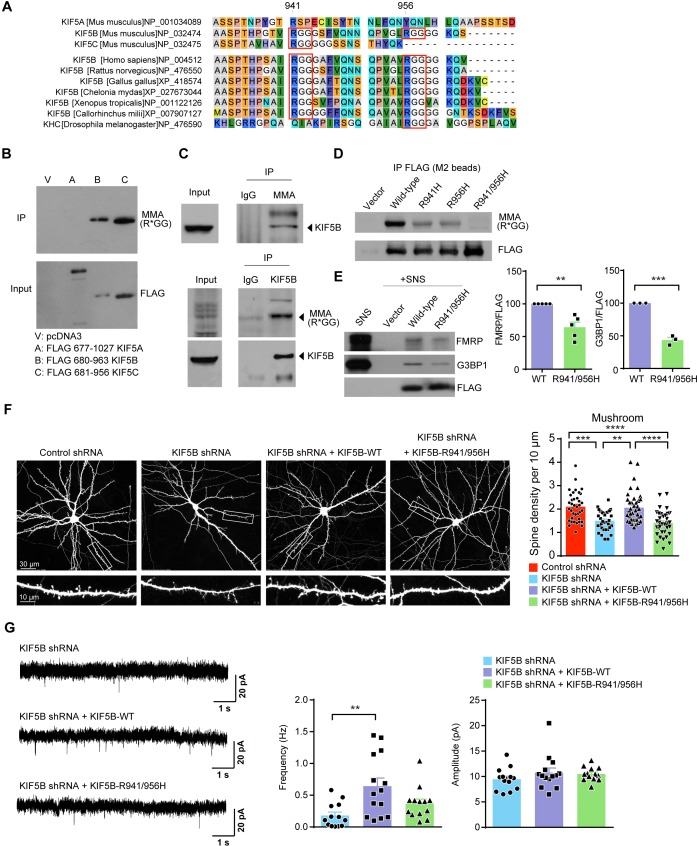
Mono-methylation of arginine near carboxyl-terminus of KIF5B is required for the formation of mushroom spines.(A) Amino acid alignment of the carboxyl-termini of KIF5A, KIF5B and KIF5C. Two conserved arginine residues (R941 and R956) in KIF5B across different vertebrates were highlighted by red boxes. (B) Carboxyl-terminal portions of different KIF5s were expressed in 293 T cells. After immunoprecipitation with anti-FLAG beads, proteins were immunoblotted by antibody targeting mono-arginine methylation at glycine-rich motifs [MMA (R*GG)]. Transfection with pcDNA3 (vector) served as a negative control. Only KIF5B and KIF5C but not KIF5A were arginine-methylated. (C) Methylation of KIF5B in the synaptoneurosome. Proteins were immunoprecipitated with anti-Mono-Methyl-Arginine antibody (MMA) and immunoblotted with KIF5B antibody (upper panel). Reciprocal immunoprecipitation using KIF5B antibody was performed to verify the arginine methylation pattern (lower panel). (D) Methylation-deficient mutants of KIF5B were constructed by single or double substitution of the two arginine residues to histidine. Vector and FLAG-tagged KIF5B constructs were transfected into 293 T cells. After immunoprecipitation with anti-FLAG beads, proteins were immunoblotted by antibody targeting mono-arginine methylation at glycine-rich motifs [MMA (R*GG)]. Mono-methylation of KIF5B was abolished by substitution of both arginine sites by histidine (R941H/R956H). (E) Reduced amount of FMRP and G3BP1 was pulled down by methylation-deficient (R941/956H) mutant of KIF5B (five independent experiments for FMRP and three independent experiments for G3BP1; mean + SEM; **p<0.01; ***p<0.001; Student’s t-test). (F) Representative images of dissociated rat hippocampal neurons co-transfected with GFP and KIF5B-shRNA together with either RNAi-resistant wild-type or the methylation-deficient (R941/956H) KIF5B construct. Co-expression of wild-type but not the methylation-deficient mutant KIF5B rescued the loss of mushroom spines induced by the KIF5B-shRNA (35–38 neurons of each group from three independent experiments were quantified; mean + SEM; **p<0.01, ***p<0.001, ****p<0.0001; Kruskal-Wallis test). (G) Representative traces of mEPSCs of KIF5B-shRNA co-expressed with RNAi-resistant wild-type or the methylation-deficient (R941/956H) KIF5B construct were shown. Co-expression of wild-type KIF5B, but not methylation-deficient KIF5B, reversed the reduction of mEPSC frequency caused by KIF5B knock-down (13–14 neurons from five independent experiments were quantified for each experimental condition; mean + SEM; **p<0.01; Kruskal-Wallis test).
Figure 5—source data 1.Plotted values for Figure 5.